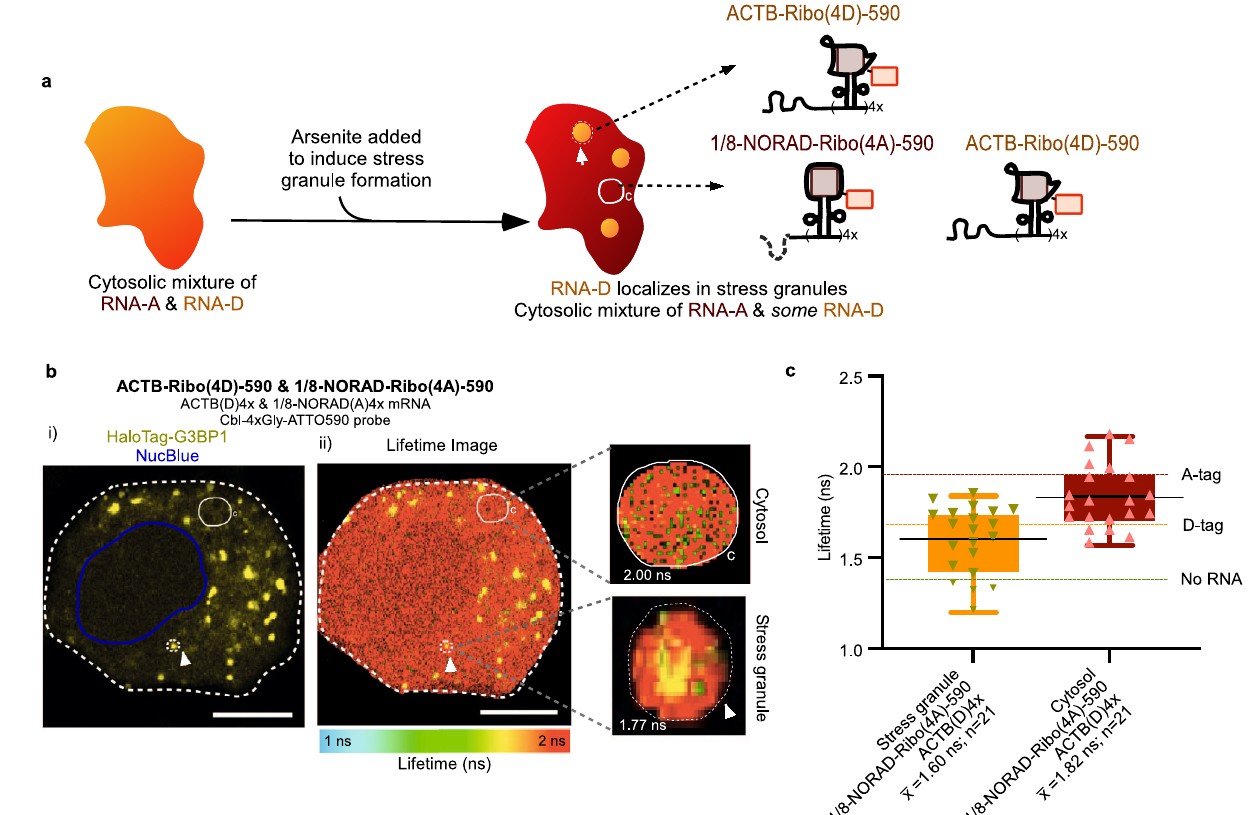
Fig. 7 | Differential recruitment of two different model RNAs tagged with Riboglow-FLIM to stress granules (SG) in live cells. a Cartoon illustration of simultaneously detecting subcellular localization of two RNAs via Riboglow RNA tags(A,D)thatexhibitdistinctlifetimevalues. b Representativeimagesofarsenite- stressed HaloTag-G3BP1 U-2 OS cells simultaneously producing ACTB-Ribo(4D) − 590 and 1/8-NORAD-Ribo(4A) − 590. The Riboglow-tagged reporter was trans- fected together with a transfection marker, JF646 dye was added to mark the SG marker protein HaloTag-G3BP1, and the nucleus was labeled via NucBlue. Left: fl uorescence intensity image showing SG and nucleus, and illustrating how SGs